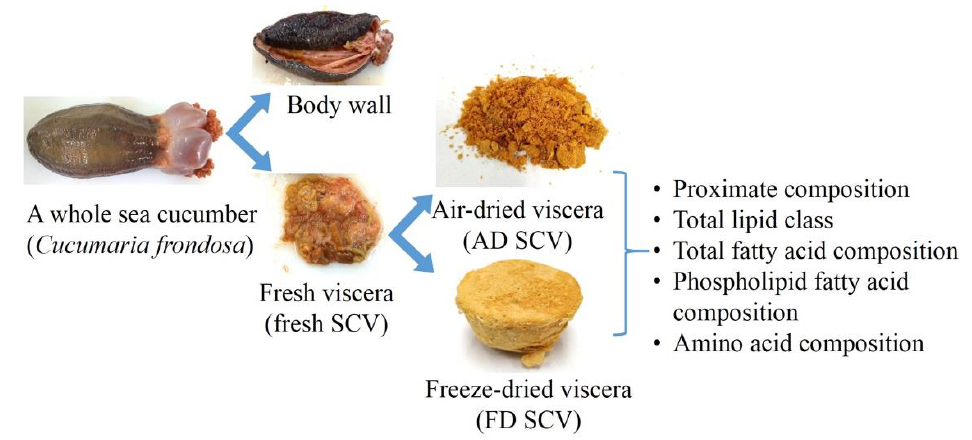
Figure 1. Experimental design of drying sea cucumber ( Cucumaria frondosa ) viscera, analyzing their nutritional profiles.